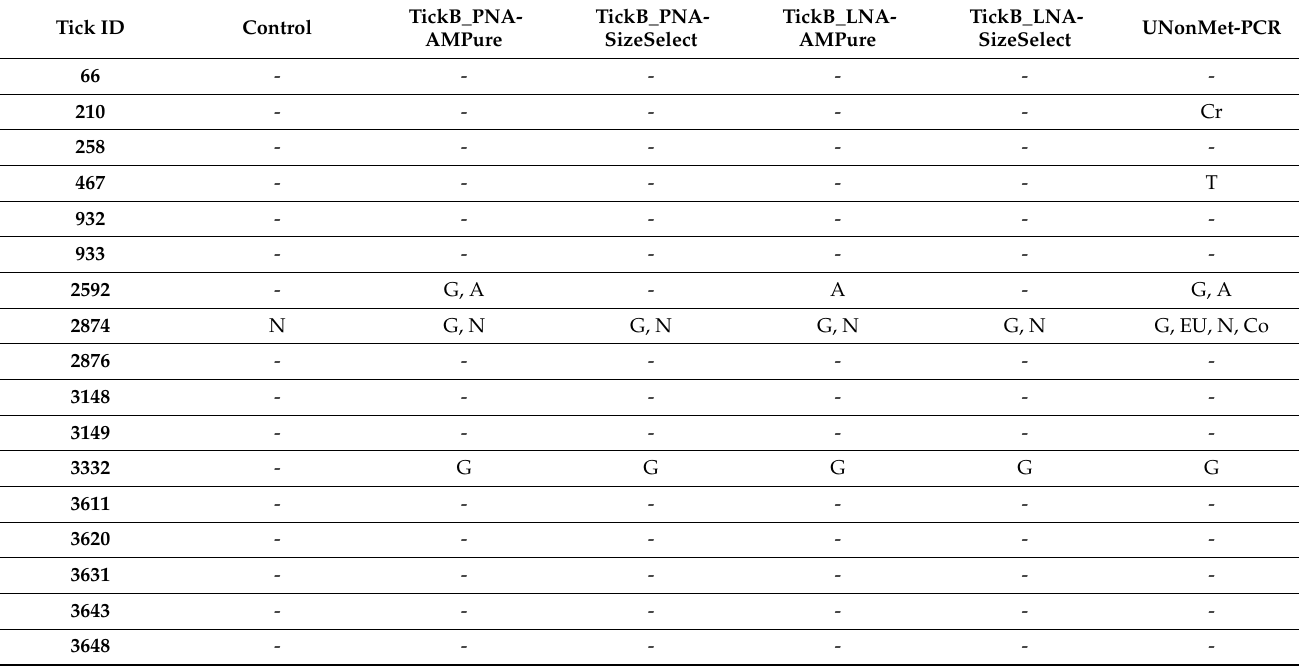
Table 4. Detected genera in the phylum